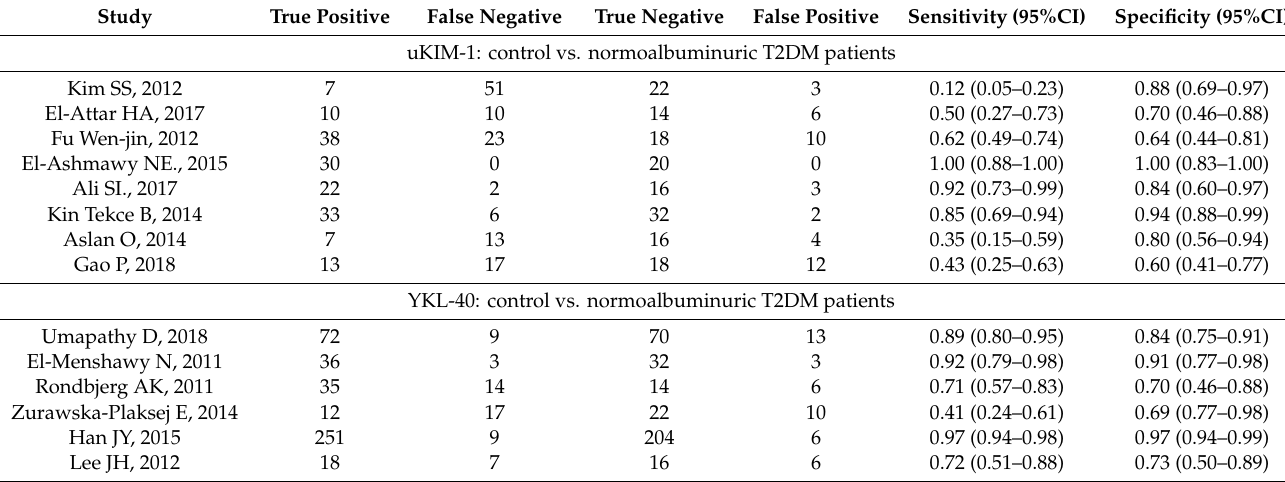
Table 3. Contingency table for uKIM-1 and YKL-40 inT2DM patients along with paired sensitivity and specificity of individual studies for the diagnosis of early DN in each study included in the meta-analysis.